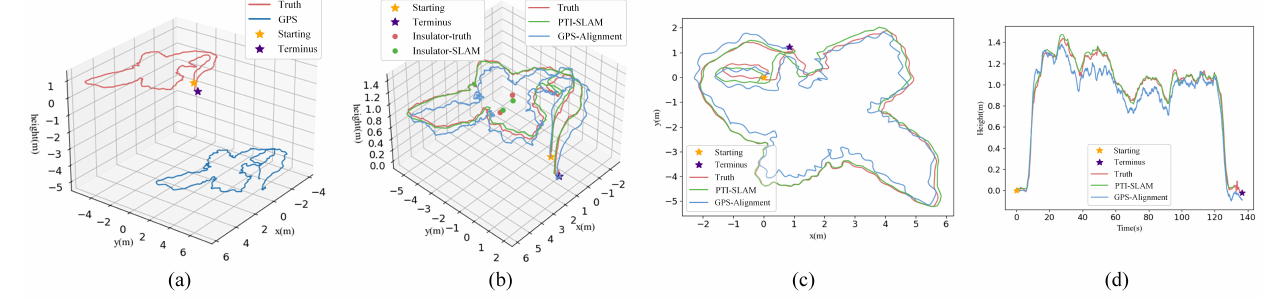
Figure 8. The trajectory comparison of PTI-SLAM and GPS. ( a ) Trajectory drawn by airborne GPS. ( b ) Trajectory comparison of the proposed PTI-SLAM and GPS-alignment in 3D view. ( c , d ) Horizontal and vertical components of